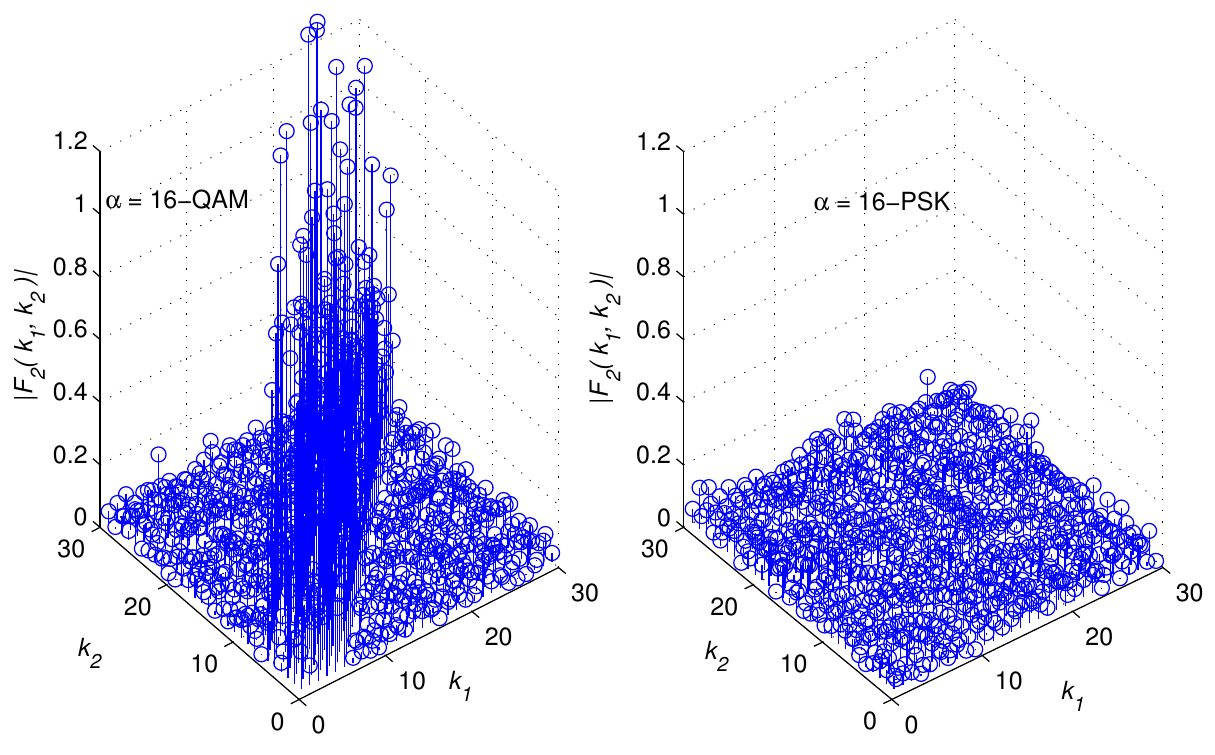
Figure 3. | F 2 ( k 1 , k 2 ) | for 16 − QAM and 16 − PSK modulations.